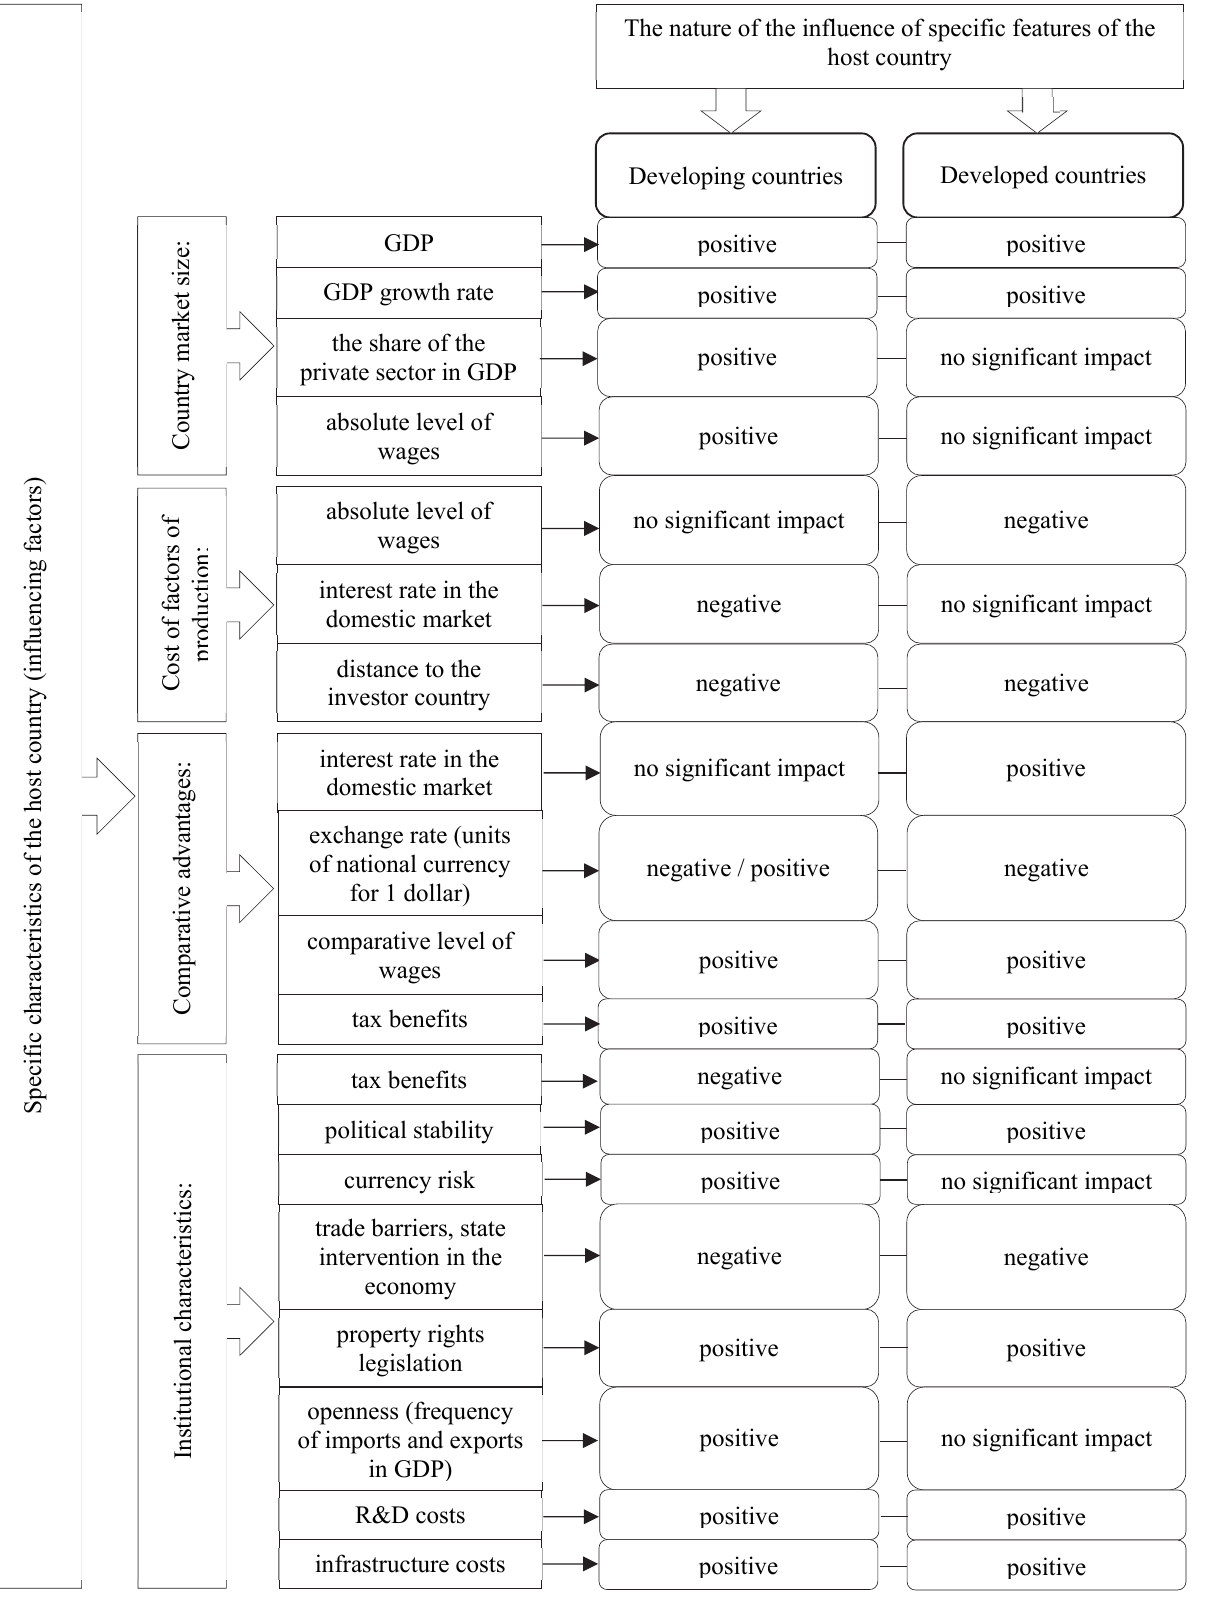
Fig. 1. Classification of factors influencing FDI attraction for developed and developing